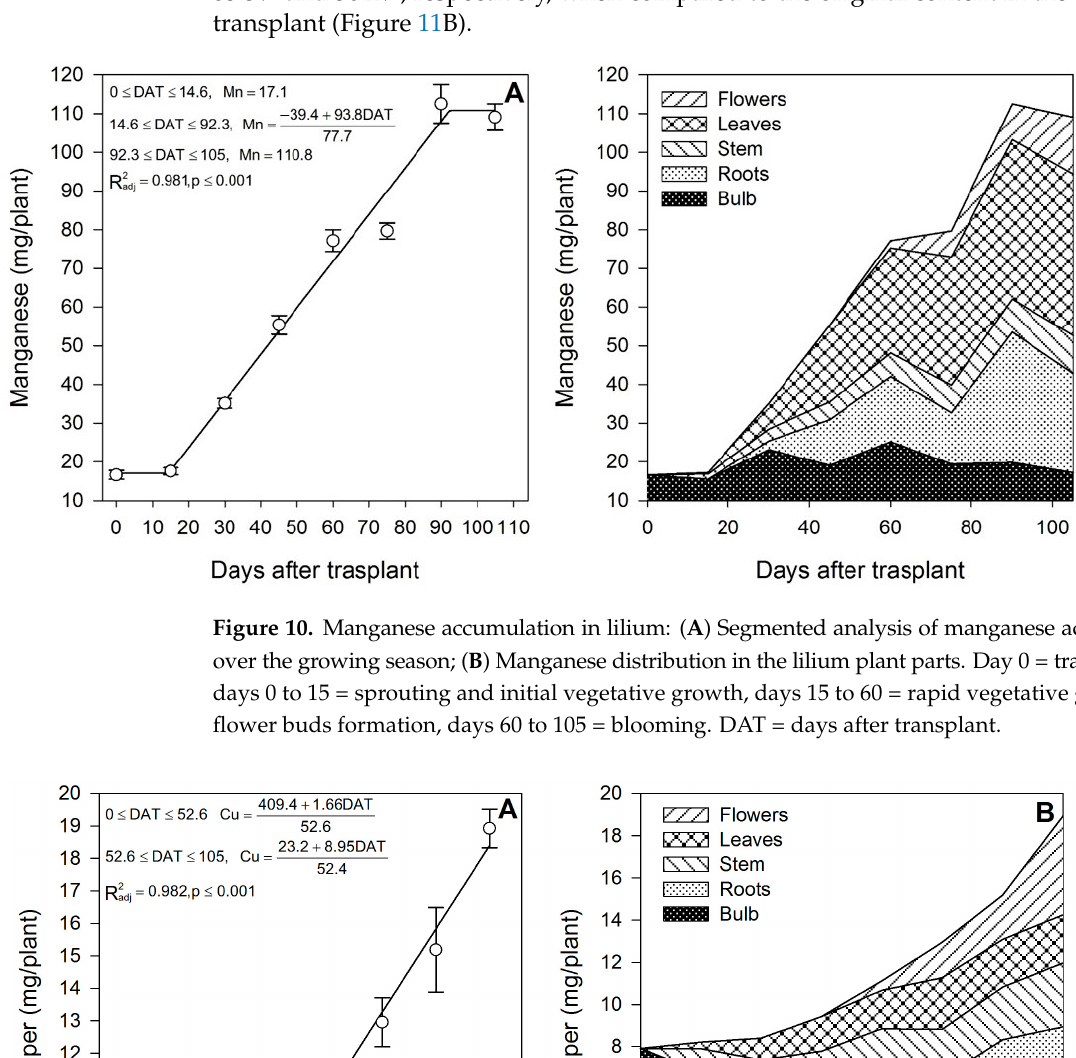
Figure 9. Zinc accumulation in lilium: ( A ) Segmented analysis of phosphorus accumulation over the growing season; ( B ) Phosphorus distribution in the lilium plant parts. Day 0 = transplant day, days 0 to 15 = sprouting and initial vegetative growth, days 15 to 60 = rapid vegetative growth plus fl ower buds formation, days 60 to 105 = blooming. DAT = days after transplant.